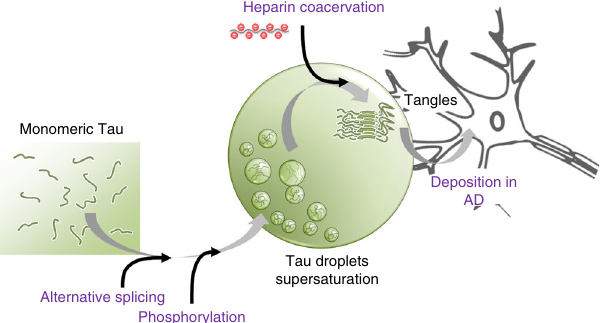
Fig. 9 Isoform-speci fi c and phosphorylation-dependent LLPS of the microtubule-binding domain of Tau is important for amyloid formation. Schematic representation illustrating liquid – liquid demixing of Tau repeats as an important step in the cascade of aberrant Tau misfolding